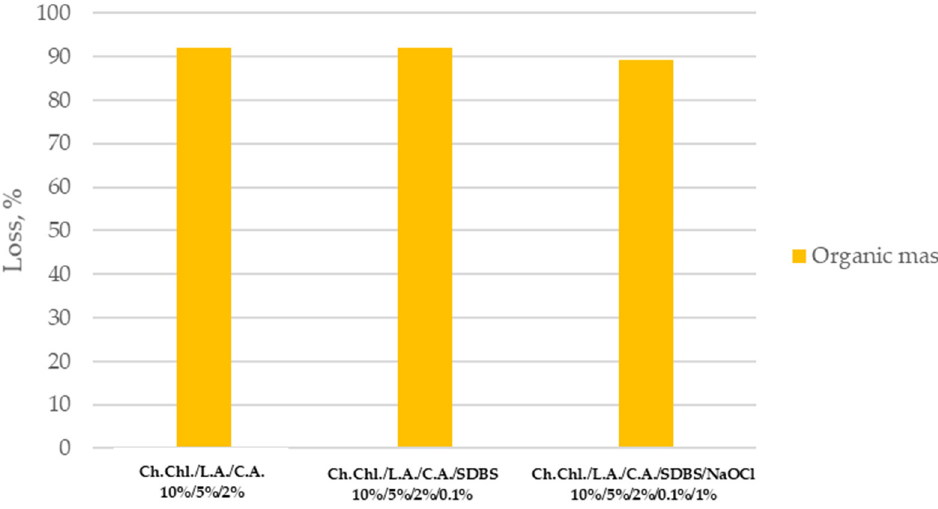
Figure 3. Organic mass loss% of DPF for various reagents solutions.